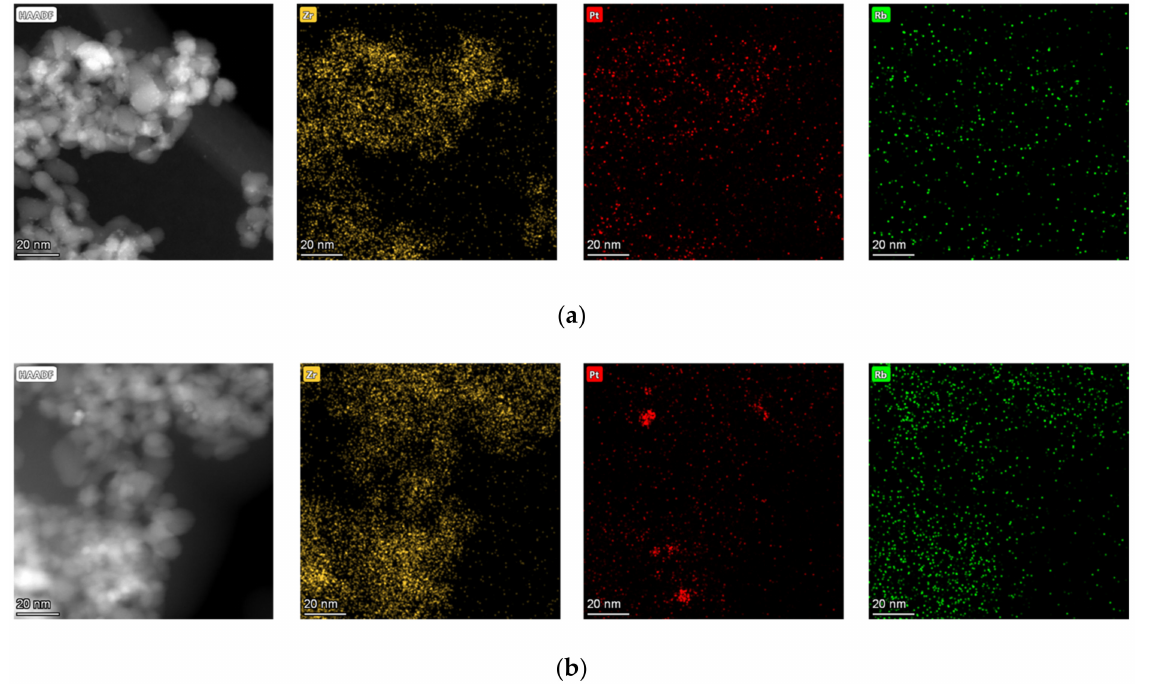
Figure 1. Transmission electron microscopy (TEM) and scanning transmission microscopy with energy-dispersive X-ray spectroscopy (STEM-EDX) images for the ( a ) 0.93% Rb-2% Pt/ZrO 2 catalyst and ( b ) the 9.29% Rb-2% Pt/ZrO 2